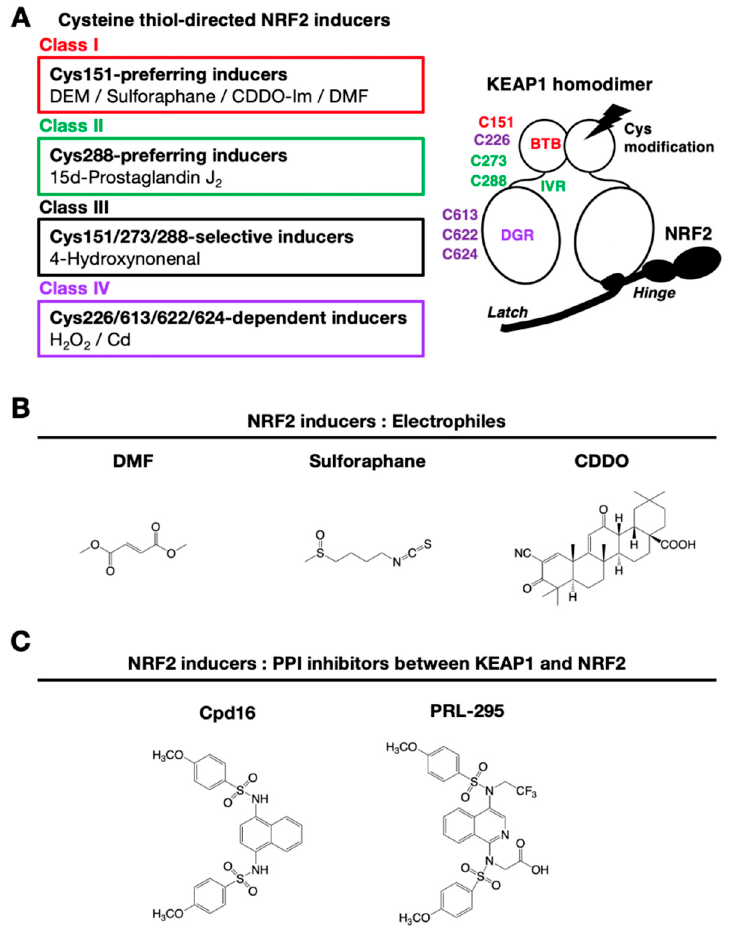
Figure 5. Multiple types of chemical inducers for NRF2. ( A ) Classification of cysteine thiol-directed NRF2-inducers. ( B ) Electrophilic NRF2-inducers: DMF, sulforaphane and CDDO. ( C ) NRF2-inducers that inhibit the protein–protein interaction of KEAP1 and NRF2: compound 16 (Cpd16) and the derivative, PRL-295.